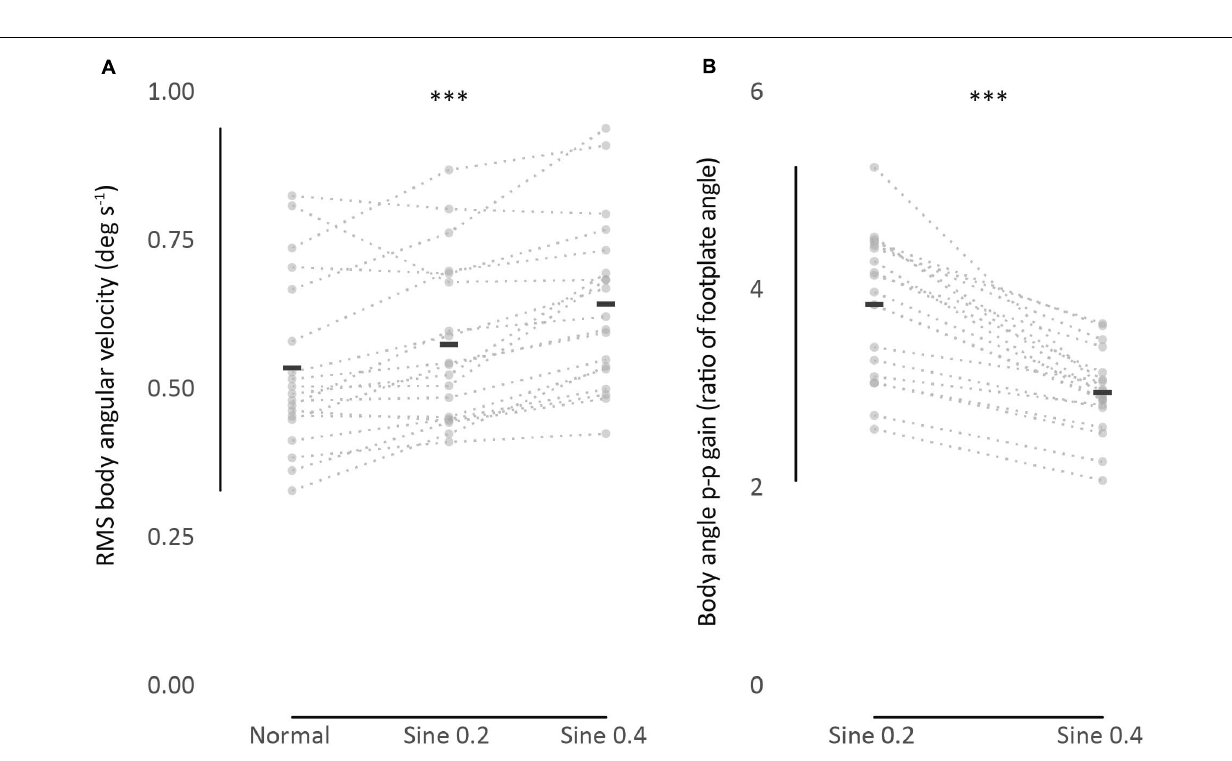
Frontiers in Human Neuroscience |